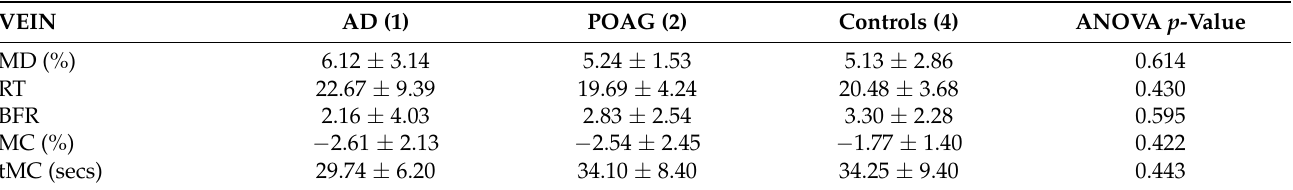
Table 4. Venous Vascular Function Parameters Determined Using Dynamic Retinal Vessel